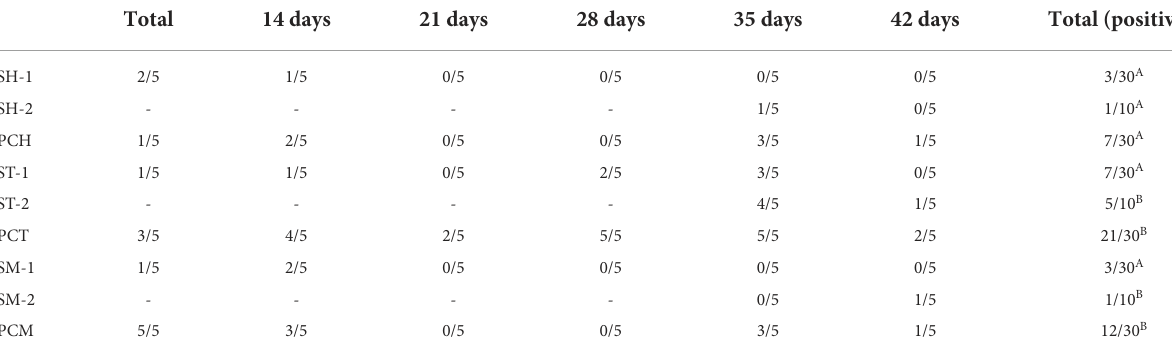
TABLE 2 Isolation of respective Salmonella serovars by cloacal